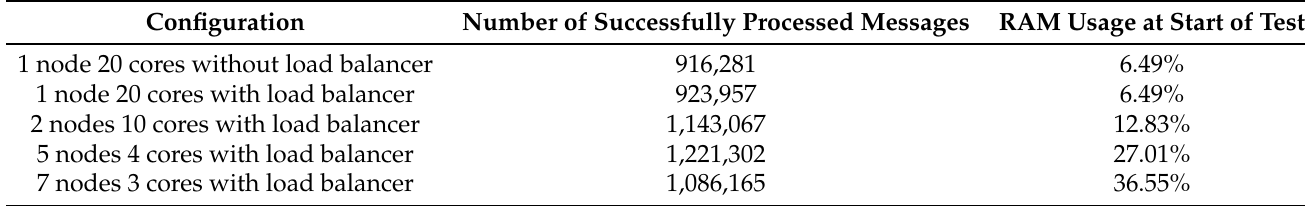
Table 1. Comparison of performance at optimal load point and memory usage.